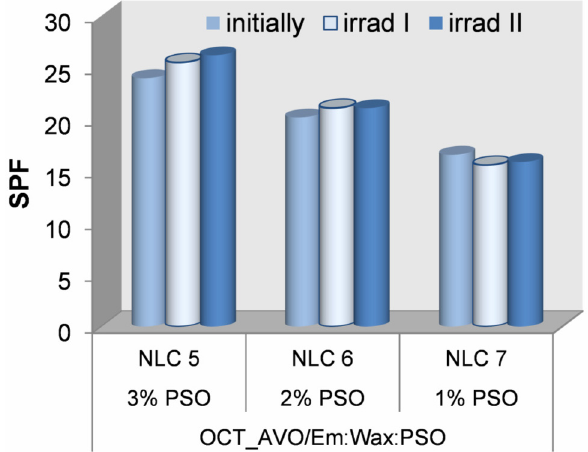
Figure 13. SPF values of the cosmetic creams based lipid nanocarriers co-loaded with UV-filters (2.6% OCT and 1.1%